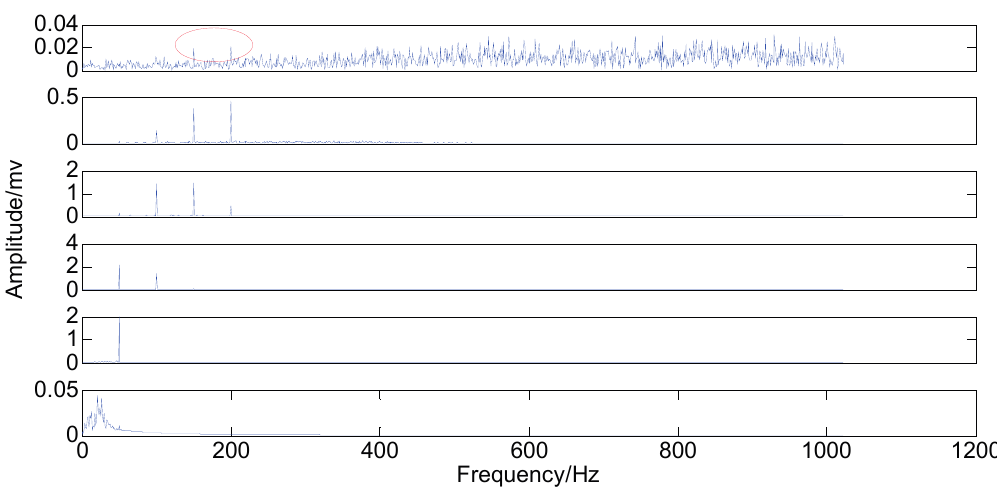
Figure 9. Optimized IMFs in the